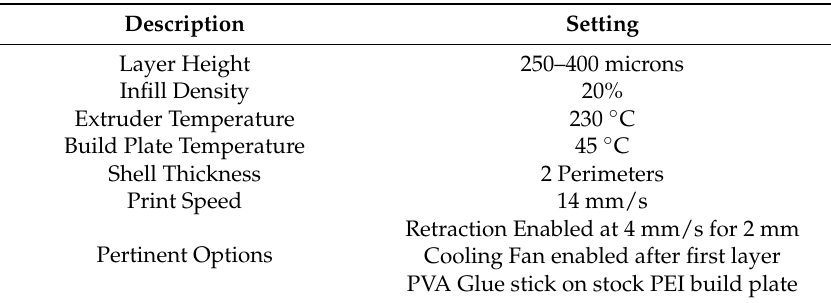
Table 1. The 3-D Printing Parameters.